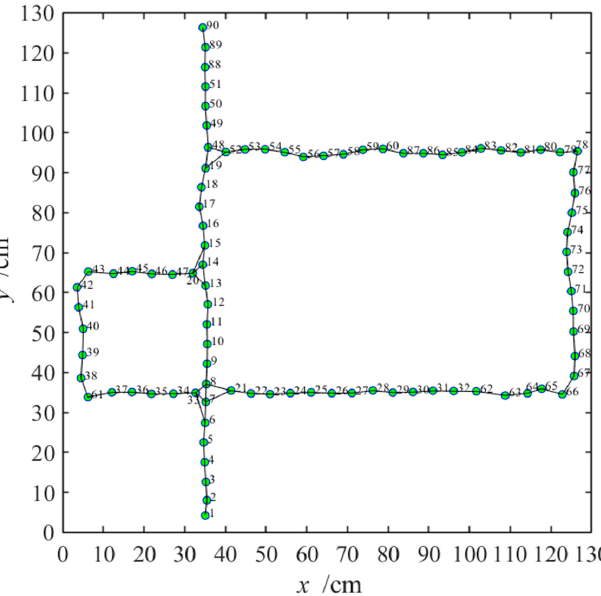
Figure 13. Cognitive map with numbered place cells according to the generation sequence. The green circles and black lines represent the cognitive map. Numbers next to the circle represent the generation order of place cells.